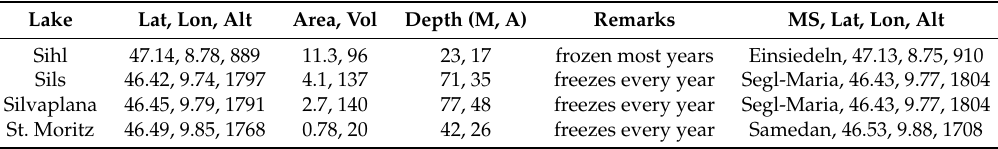
Figure 1. On the first row, left image shows the orthophoto map of Switzerland (source: Swisstopo [44]). Regions around the four target lakes (shown as blue and yellow rectangles on the map) are zoomed in and shown on the right side of the map (lake Sihl on the left, region around lakes Sils, Silvaplana, St. Moritz on the right). On the second row, the image footprints of two webcams monitoring lake St. Moritz are displayed (Camera 0 and 1 images were captured on 14 December 2016 and 13 December 2016 respectively when the lake was partially frozen). Best if viewed on screen. Table 2. Characteristics of the target lakes (data mainly from Wikipedia). Latitude (lat, ◦ North), longitude (lon, ◦ East), altitude (alt, m), area (km 2 ), volume (vol, Mm 3 ), and the maximum and average depth [depth(M,A)] in m are shown. Additionally, for each lake, the nearest meteorological station (MS) is shown together with the corresponding latitude, longitude, and